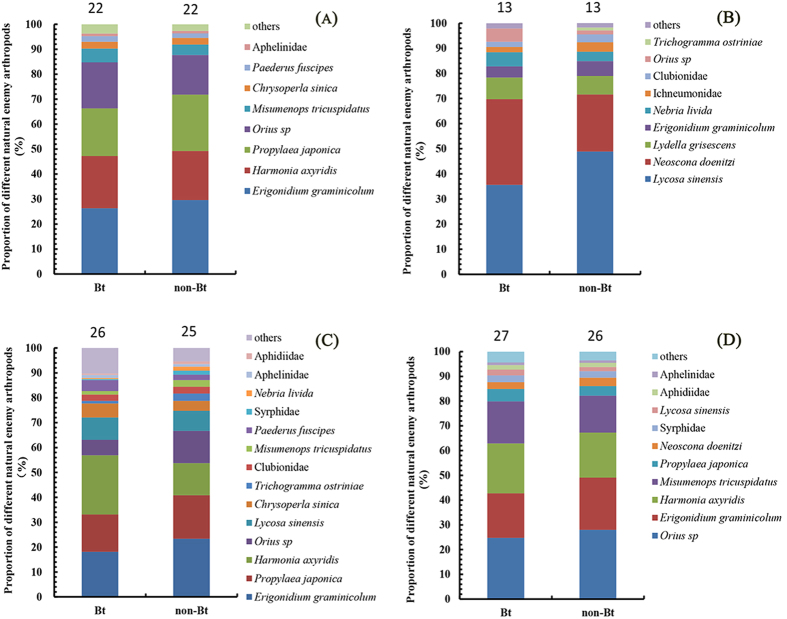
Proportional representation of natural enemies found in Bt and non-Bt maize plots in 2012 and 2013 by whole plant inspections (A), pitfall traps (B), suction sampler (C) and three methods combined (D). The Y-axis shows the percentage of each taxa and the X-axis shows the maize type. This diagram illustrates dominant natural enemies (proportion > 1%) and the total proportion of taxa with percentages below 1% (others). Numbers above the columns show the total numbers of taxa collected with each method and three methods combined.